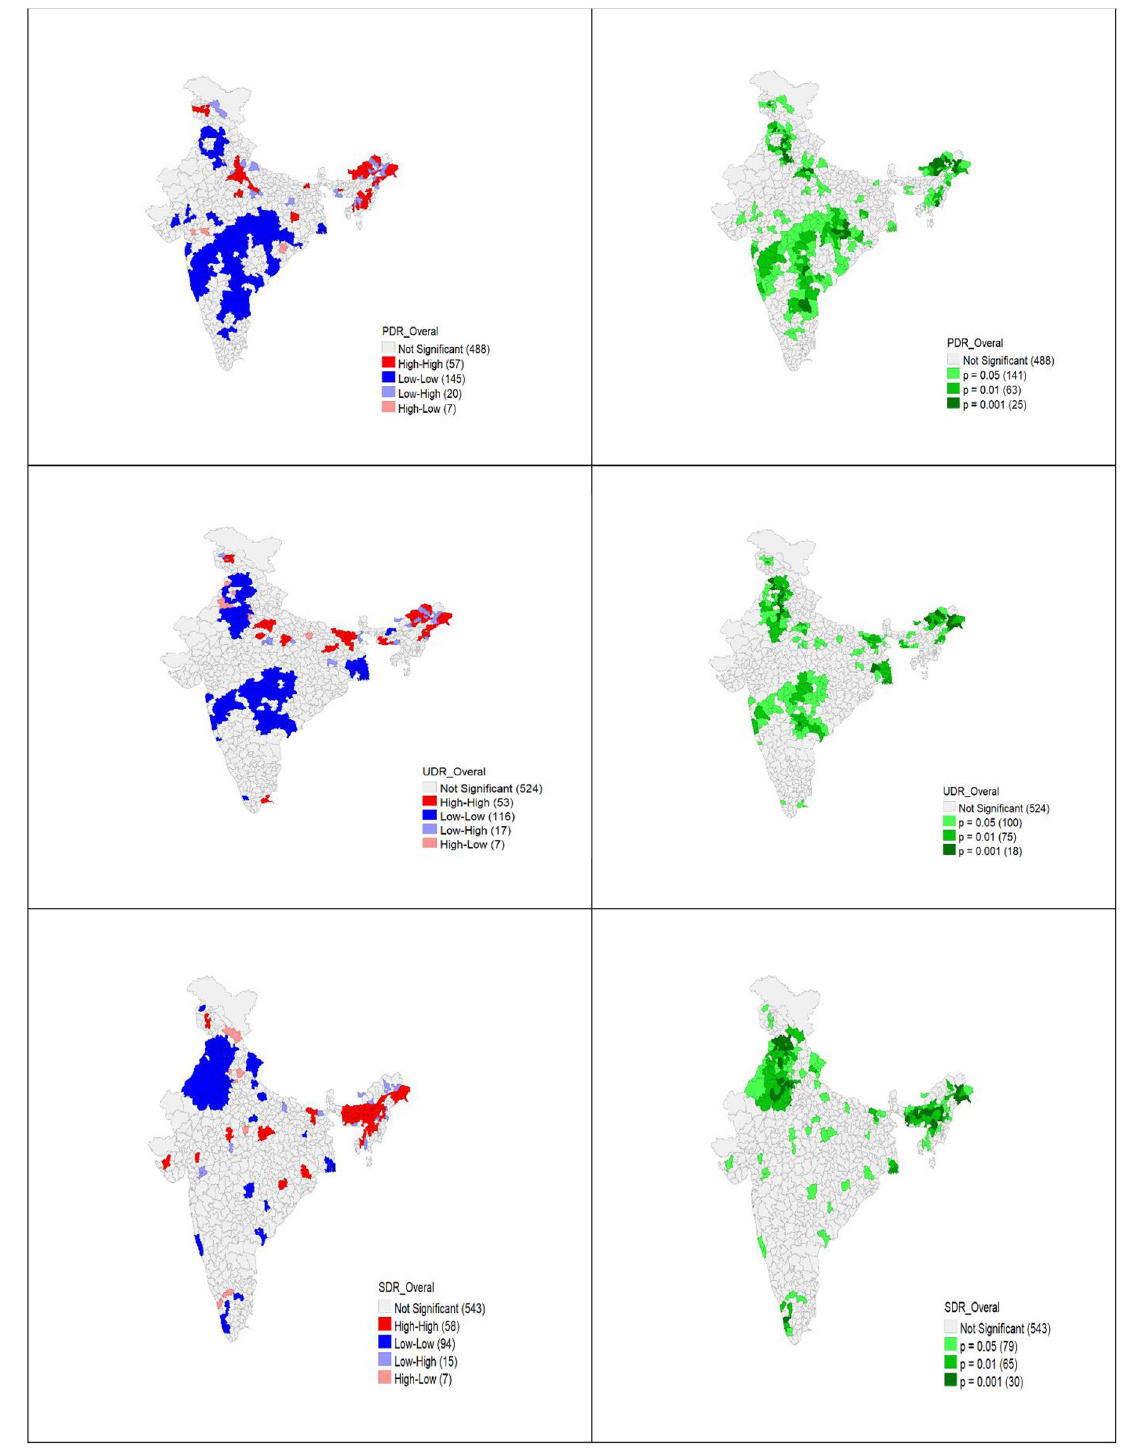
Fig 2. LISA cluster and significance maps of dropout rates across Indian districts. (A) LISA map of primary dropout rate (I = 0.349, < 0.05). (B) Significance map of primary dropout. (C) LISA map of upper primary dropout rate (I = 0.367, < 0.05). (D) Significance map of upper primary dropout. (E) LISA map of secondary dropout rate (I = 0.316, < 0.05). (F) Significance map of secondary dropout.